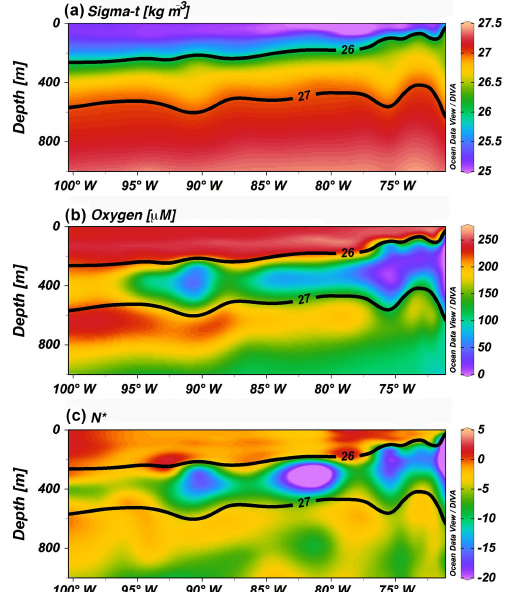
Figure 7. Vertical distributions of σ t , dissolved oxygen and nitrate deficit (N*; according to Deutsch et al., 2001) in a cross-shore transect along 28 ◦ S in the Eastern Southern Pacific Ocean (72 to 100 ◦ S) during Scorpio cruise (June 1967). Black lines refer to σ t of 26 and 27kgm − 3